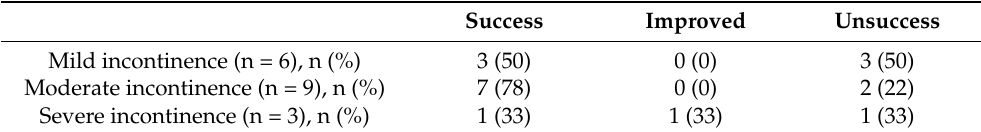
Table 3. Subgroup analysis.